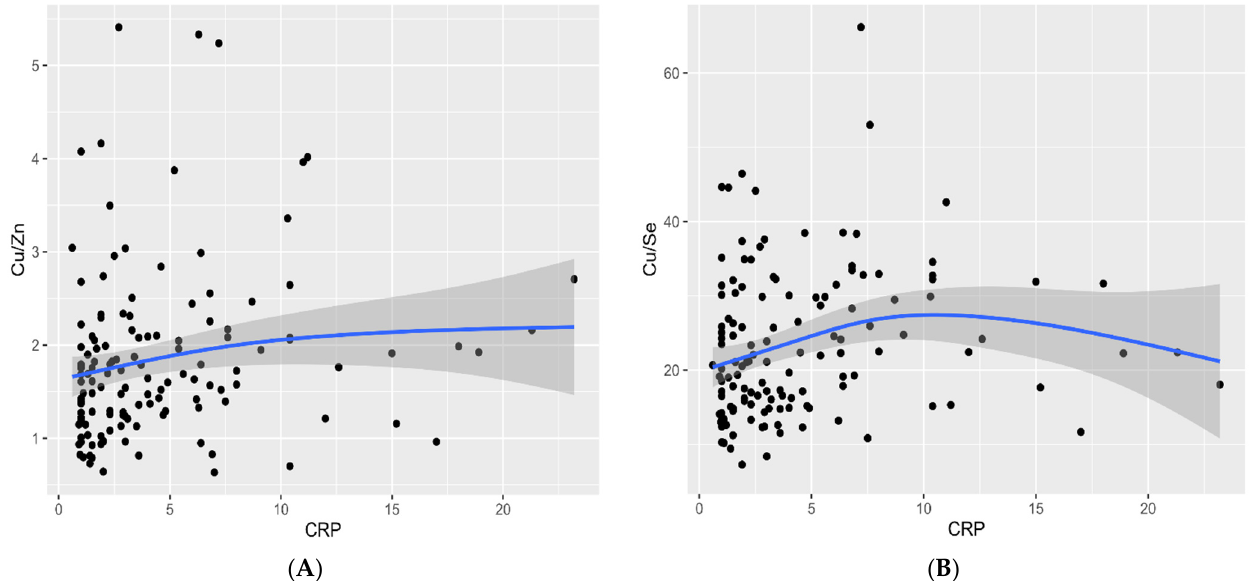
Figure 4. Correlation between Cu/Zn ( A ) and Cu/Se ( B ) molar ratio levels and CRP serum values (mg/L) in patients with acute ischemic stroke (AIS). Abbreviations: Cu, Copper. Zn, Zinc. Se, Selenium. CRP, C-reactive protein.